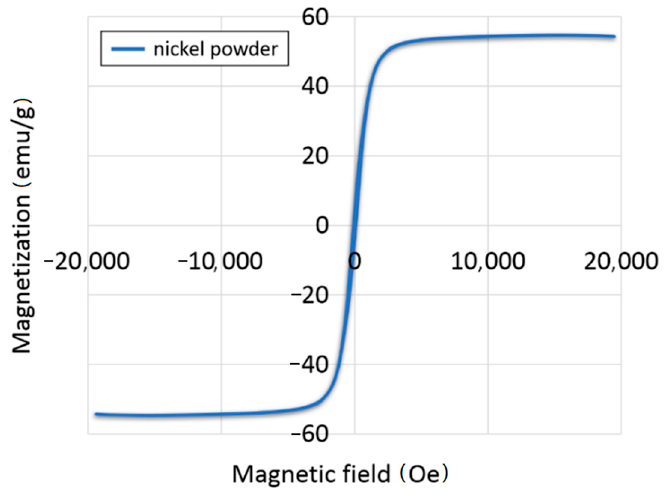
Figure 2. Ferroelectric hysteresis loop of magnetic nickel powder.